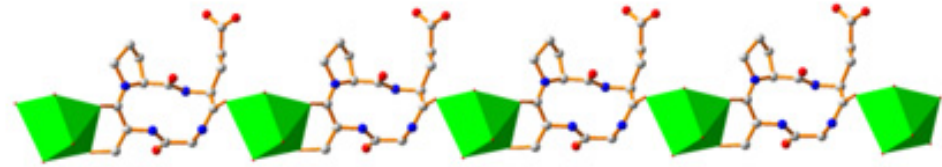
Figure 3. View of the 1D linear chain of 2 along [001] direction. Color code: green, Pb; gray, C; blue, N; red, O.